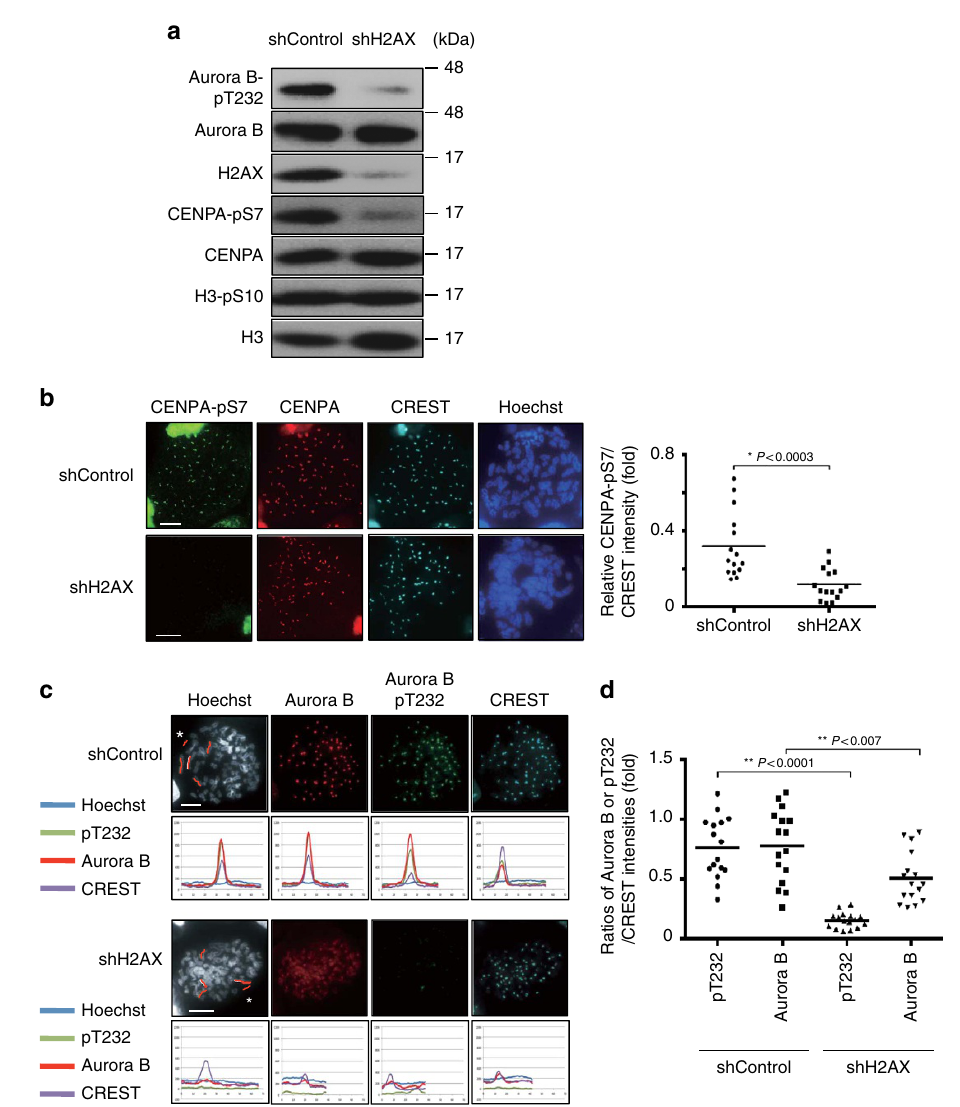
Figure 3 | Aurora B-mediated H2AX-pS121 is a prerequisite for proper activation and deposition of Aurora B at centromeres. ( a ) HeLa cells expressing the Dox-inducible shControl or shH2AX were treated as in Fig. 2d. Chromatin fractions from mitotic cells were subjected to immunoblotting with the indicated antibodies. ( b ) Metaphase spreads from HeLa cells expressing shControl or shH2AX in the presence of doxycycline (1 m gml (cid:2) 1 ) were fixed and stained with antibodies against CENPA-pS7 (green), CENPA (red) and CREST (aqua). DNA was counterstained with Hoechst (blue). Representative images are shown (left). Scale bars, 10 m m. Signal intensities of CENPA-pS7 at the centromere were measured (right) and CREST was used as a control of the centromeric signal intensity ( n ¼ 15 cells, 5 kinetochores were measured per each cell, Student’s t -test). ( c ) Representative images of metaphase spreads from HeLa cells expressing shControl or shH2AX cells in the presence of doxycycline (1 m gml (cid:2) 1 ) (upper and third panels). Fluorescence intensities scanned along with each chromosome are indicated by red lines (second and bottom panels). Red lines marked with asterisks indicate negative backgrounds (upper and third panels). Scale bars, 10 m m. ( d ) Mitotic spreads from HeLa cells expressing the shControl or shH2AX were performed and signal intensities of AuroraB and AuroraB pT232 at the centromere were measured. CRESTwas used as a control of the centromeric signal intensity ( n ¼ 16 cells, 5 kinetochores were measured per each cell, Student’s t